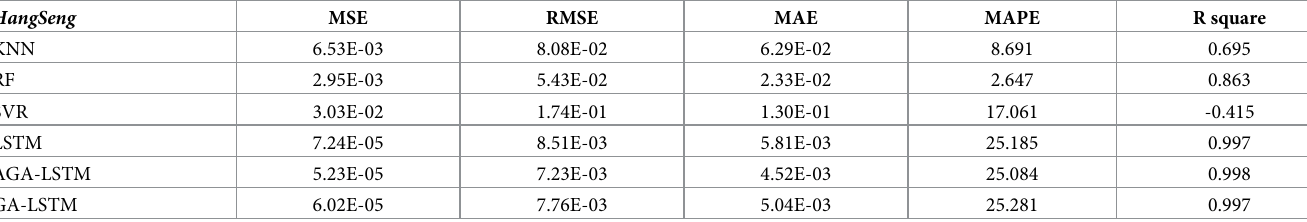
Table 9. The evaluation indexes of AGA-LSTM model and other DL models in HangSeng date set. HangSeng RF